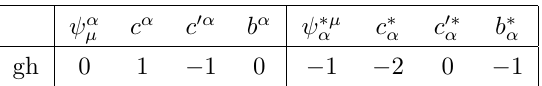
Table 2 . The ghost numbers of the fields and antifields appearing in the quantisation of the Rarita- Schwinger